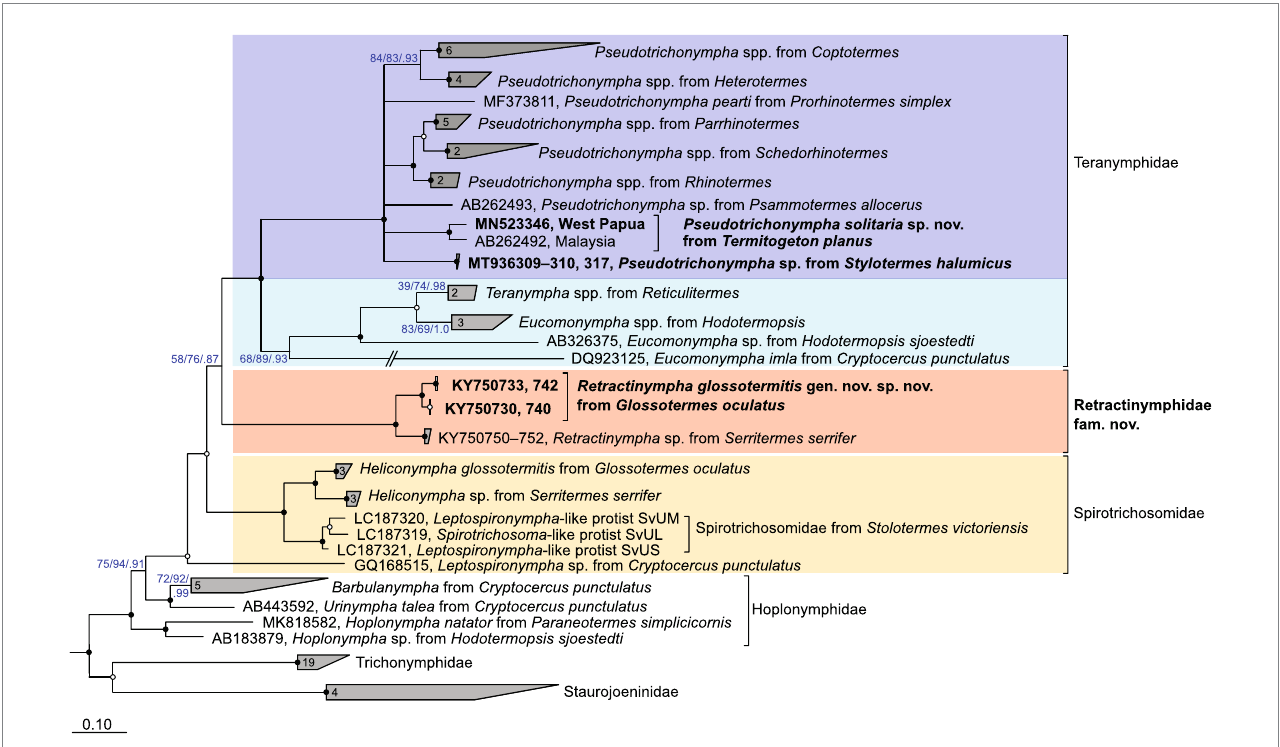
FIGURE 4 Phylogenetic analysis of the SSU rRNA genes of Trichonymphida. The position of Retractinympha glossotermitis and the Pseudotrichonympha spp. obtained in this study are shown in bold. The maximum-likelihood tree is a consensus tree from 1,000 bootstrap trees reconstructed with IQ-TREE, using Lophomonas striata and members of Trichomonadea as outgroup. Tree topology was tested with PhyML and Bayesian analysis (Ba); conflicting nodes are shown as multifurcation. Bullets indicate high node support in all analyses: SH-aLRT/ultrafast bootstrap/Ba posterior probabilities ≥ 96/99/1.00 (•), ≥ 80/95/0.98 (•); in other cases, individual values are shown. Collapsed clades are labeled with the number of sequences included. For more details, including accession numbers of all sequences, see Supplementary Figure